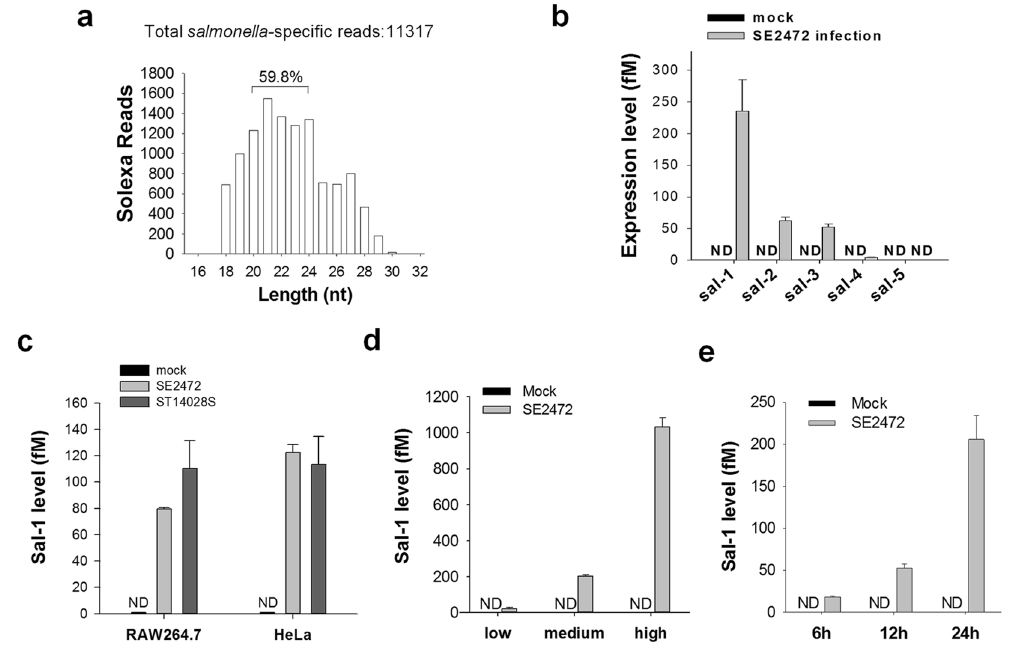
Figure 1. Production of small RNA fragments encoded by Salmonella in human intestinal epithelial cells infected by Salmonella strain SE2472. ( a ) Size distribution of Salmonella -encoded small RNA fragments. ( b ) Levels of five Salmonella -encoded small RNA fragments in HT-29 cells infected by SE2472. ( c ) Sal-1 level in RAW264.7 and HeLa cells infected with various Salmonella strains. ( d ) Sal-1 level in HT-29 cells at 12 h post- infection with SE2472 at MOI of 1 (low), 10 (medium) and 100 (high), respectively. ( e ) Sal-1 level in HT-29 cells at 6, 12 and 24 h post-infection with SE2472. The data are presented as the mean ± SEM (n = 4). ND, not